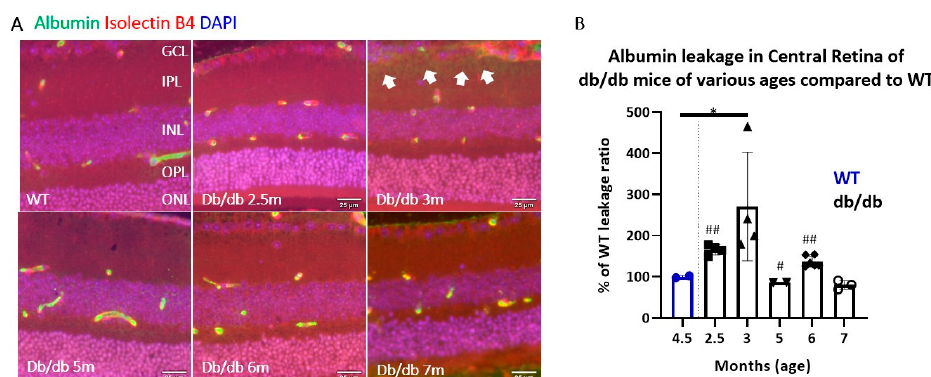
Figure A1. Albumin leakage in db/db mice of various ages. ( A ) Representative images of DAPI (blue), Isolectin B4 (red) and albumin (green) staining in 3-month old db/m (WT) and db/db mice of different ages (2.5, 3. 5, 6 and 7 months). ( B ) Quantification of albumin extravasation. Mean ± SD, n ≥ 2 mice per group. * p < 0.05 by One Way ANOVA. # p < 0.05, ## p < 0.01, compared to WT controls by unpaired t -test.